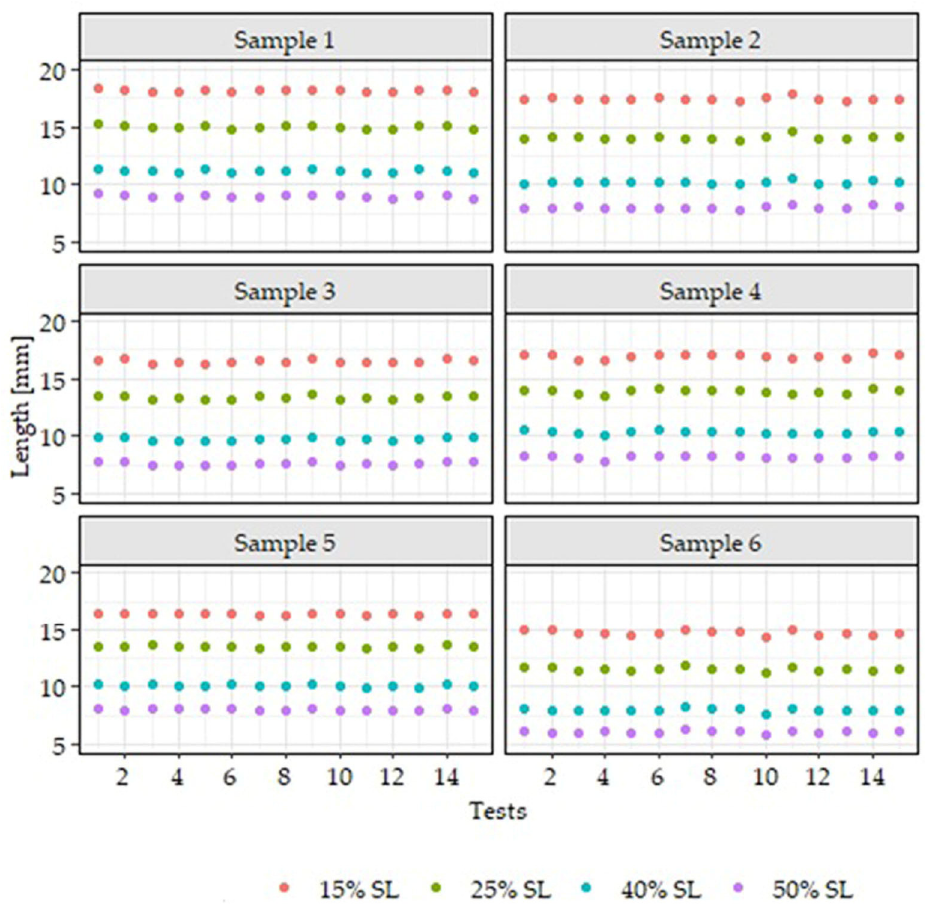
Figure 5. Scatter plots of fibrogram measurements taken over eight weeks (long-term study). Indi- vidual data points represent the average of 10 replications. The span lengths shown are all extracted from the fibrogram.